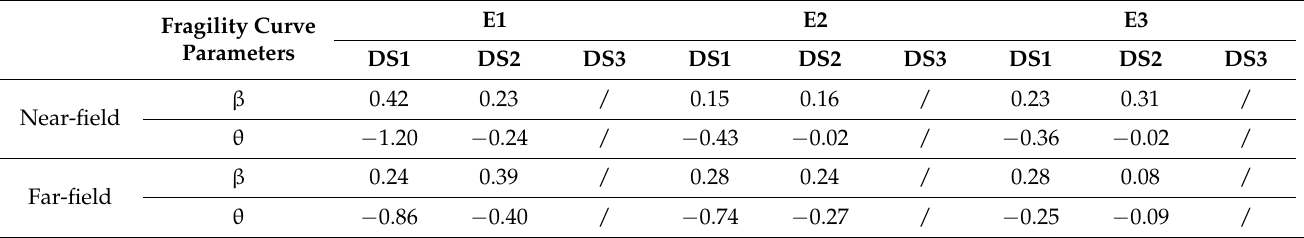
Table 6. Fragility curve parameters considering the influence of H/B ratios on near-field and far-field earthquake records.